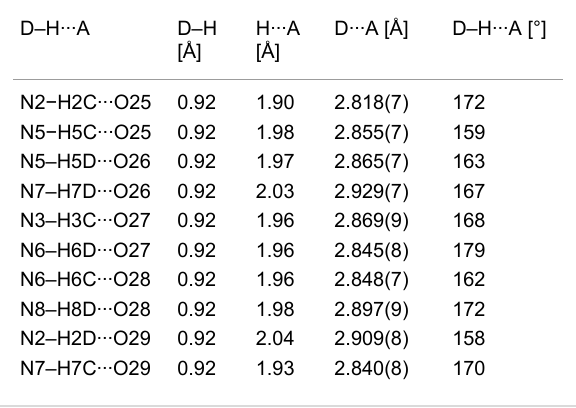
Table 2: Selected hydrogen-bond lengths (Å) and bond angles (°) of complex 1 .